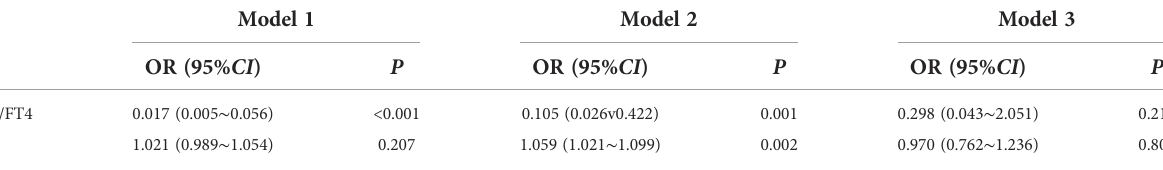
TABLE 7 Multivariate logistic regression analysis of the association between FT3/FT4 ratio, VAI and NFS status for NAFLD positive